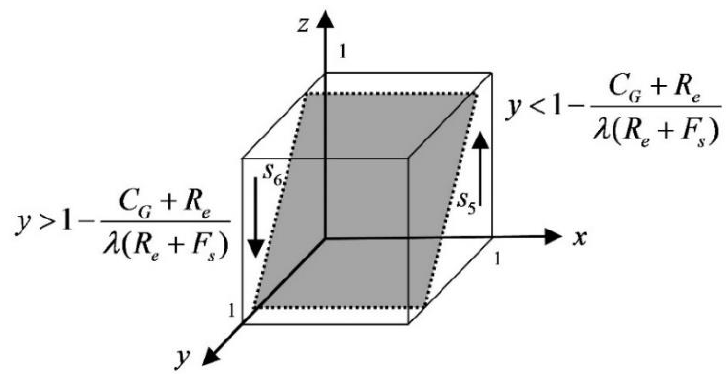
Figure 4. The government dynamic trend phase diagram.